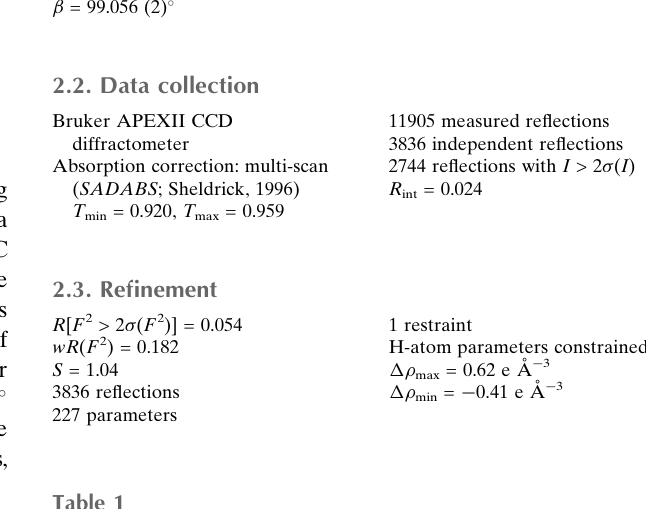
Hydrogen-bond geometry (A˚ , (cid:2)